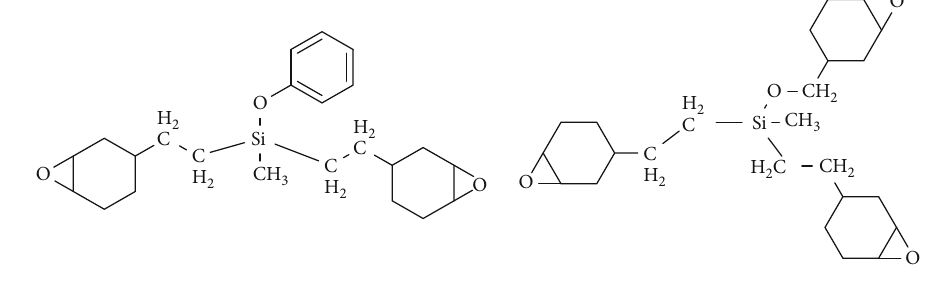
Figure 3: Chemical structure of silicon-containing cycloaliphatic epoxy resin.